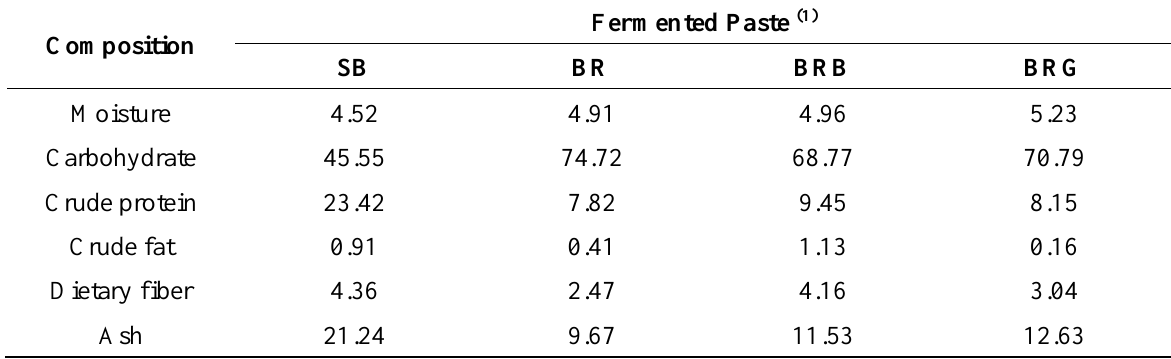
Table 1. Proximate composition (% dry basis) of the fermented paste samples.